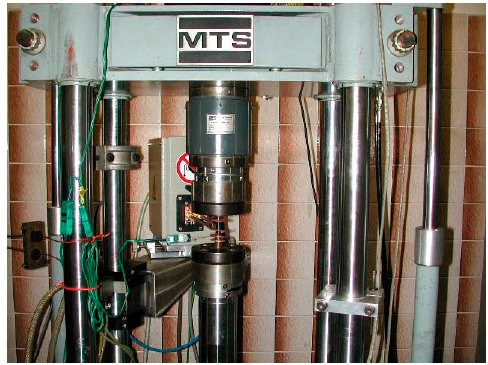
Figure 3. MTS-810 testing machine used in low-cycle testing.